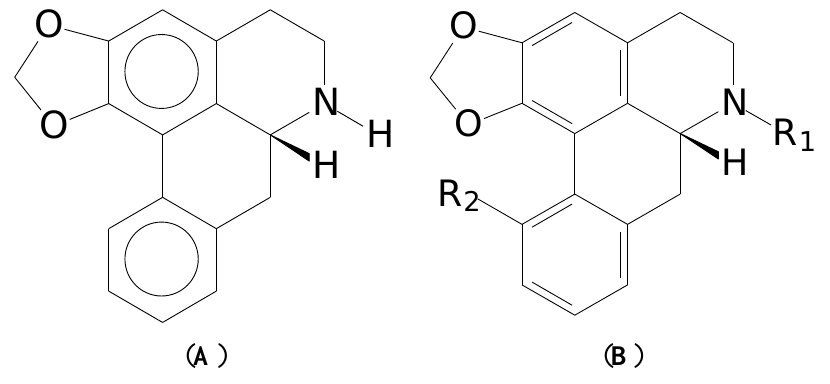
Figure 1. Chemical structure of (−)-anonaine ( A ) and anonaine derivative (B).